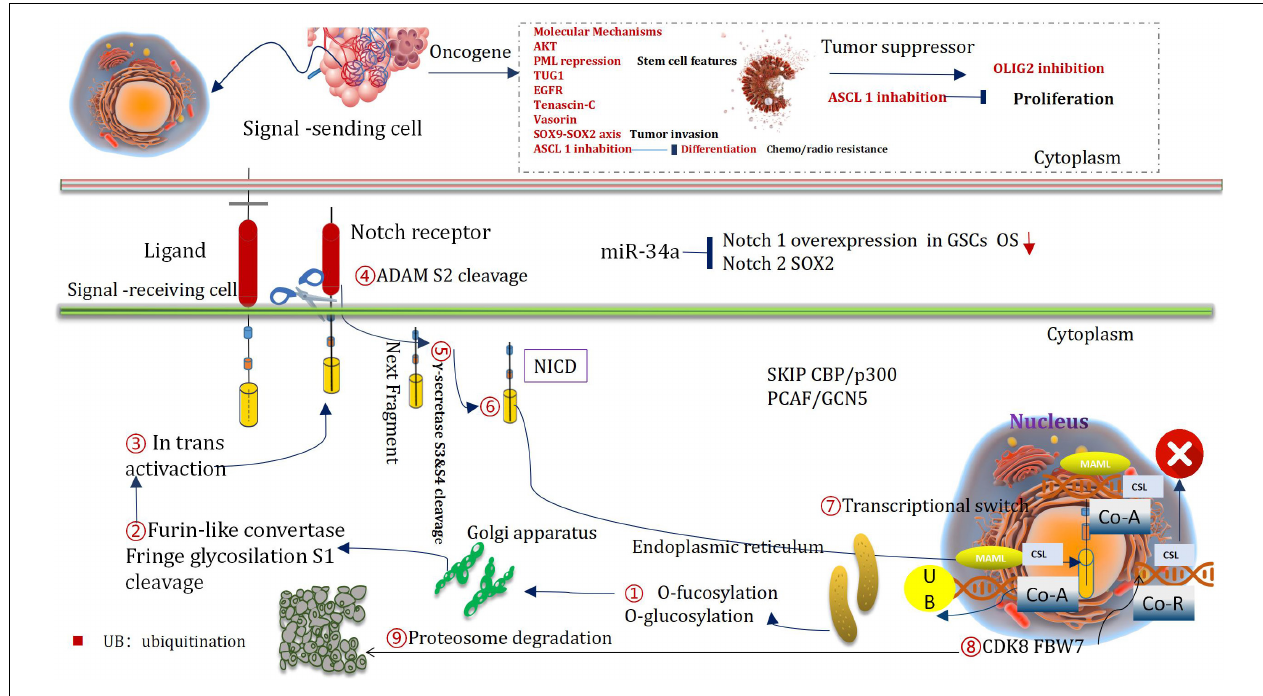
FIGURE 7 | He regulatory mechanism of notch in